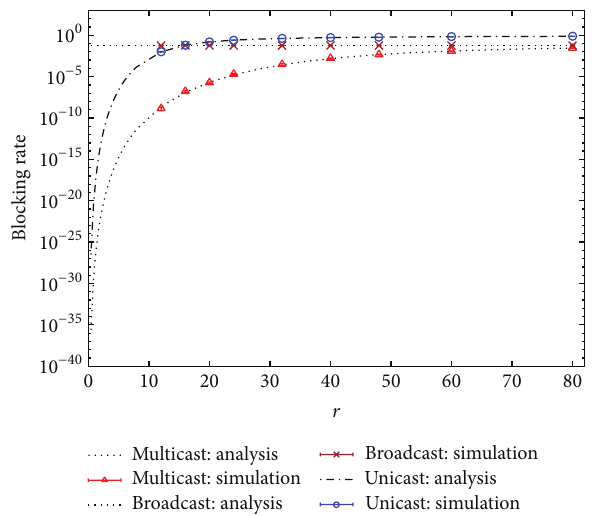
Figure 2: Blocking rates of unicast, broadcast, and multicast IPTV services. (Hit rate distribution: uniform.)